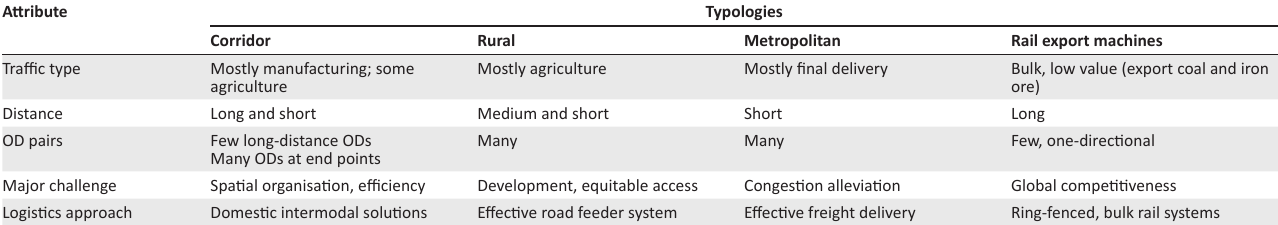
TABLE 1: Definition of South Africa’s freight transport typologies.